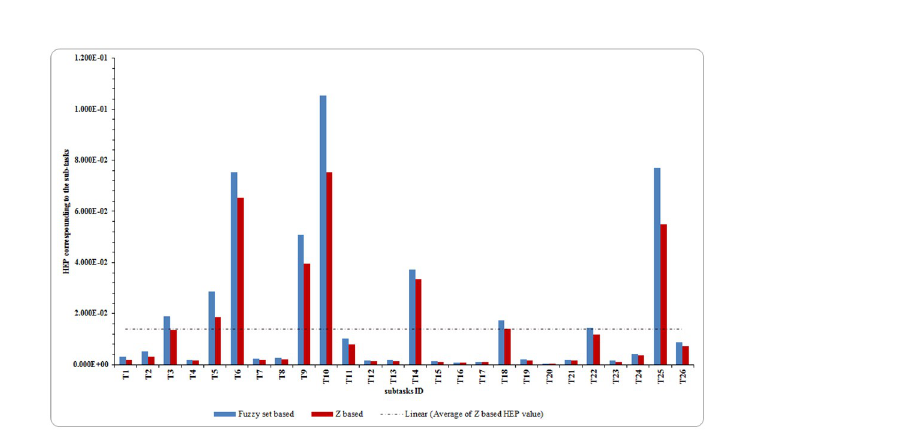
Fig 7. HEP distribution for subtasks of de energization power